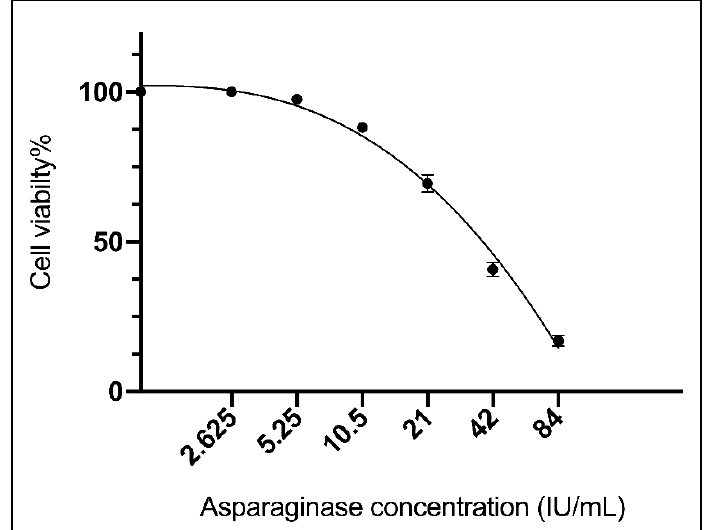
Figure 4. Viability response of M-NFS-60 cell line against serial two-fold dilutions of purified asparaginase from L. theobromae